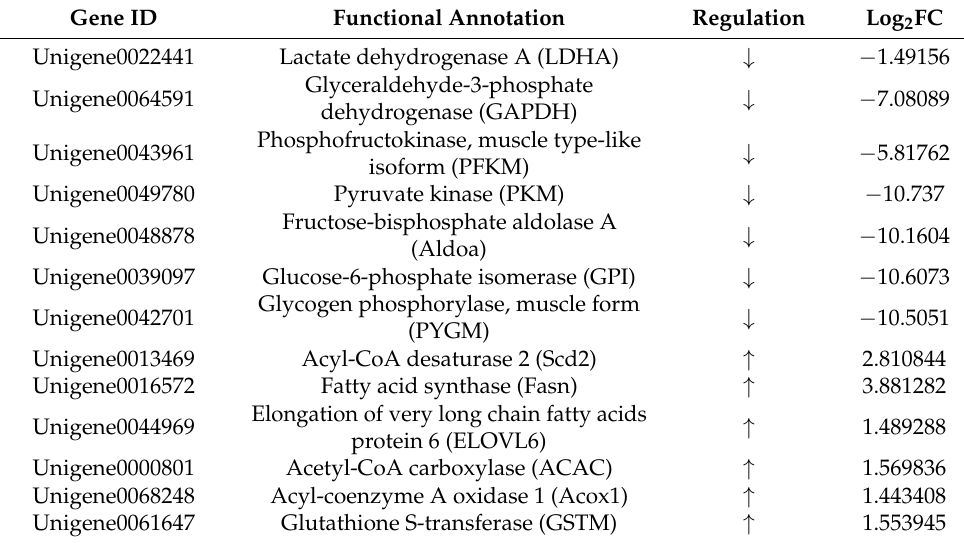
Table 1. Changes in metabolism-related differentially expressed genes in the hepatopancreas of Palaemon carinicauda in response to EHP infection. Gene ID Functional Annotation Regulation Log 2 FC Unigene0022441 Lactate dehydrogenase A (LDHA) ↓ − 1.49156 Glyceraldehyde-3-phosphate ↓ − 7.08089 Unigene0064591 dehydrogenase (GAPDH) Phosphofructokinase, muscle type-like ↓ − 5.81762 Unigene0043961 isoform (PFKM) Unigene0049780 Pyruvate kinase (PKM) ↓ − 10.737 Fructose-bisphosphate aldolase A ↓ − 10.1604 Unigene0048878 (Aldoa) Unigene0039097 Glucose-6-phosphate isomerase (GPI) ↓ − 10.6073 Glycogen phosphorylase, muscle form ↓ − 10.5051 Unigene0042701 (PYGM) Unigene0013469 Acyl-CoA desaturase 2 (Scd2) ↑ 2.810844 Unigene0016572 Fatty acid synthase (Fasn) ↑ 3.881282 Elongation of very long chain fatty acids ↑ 1.489288 Unigene0044969 protein 6 (ELOVL6) Unigene0000801 Acetyl-CoA carboxylase (ACAC) ↑ 1.569836 Unigene0068248 Acyl-coenzyme A oxidase 1 (Acox1) ↑ 1.443408 Unigene0061647 Glutathione S-transferase (GSTM) ↑